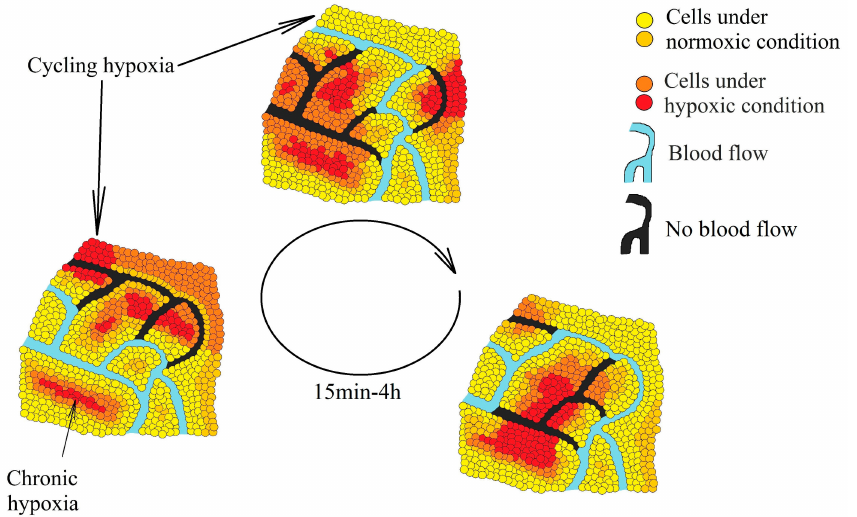
Figure 1. Two types of hypoxia in a tumor: chronic hypoxia associated with an excessive distance from the blood vessels and cycling hypoxia associated with changes in the blood flow in the vessels inside the tumor which lead to periodic oxygen deficiencies in various parts of the